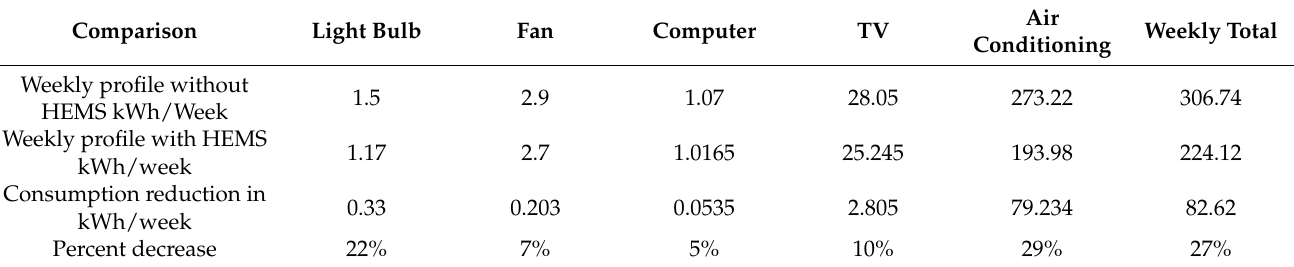
Table 11. Comparison of the Consumption profile by appliance.